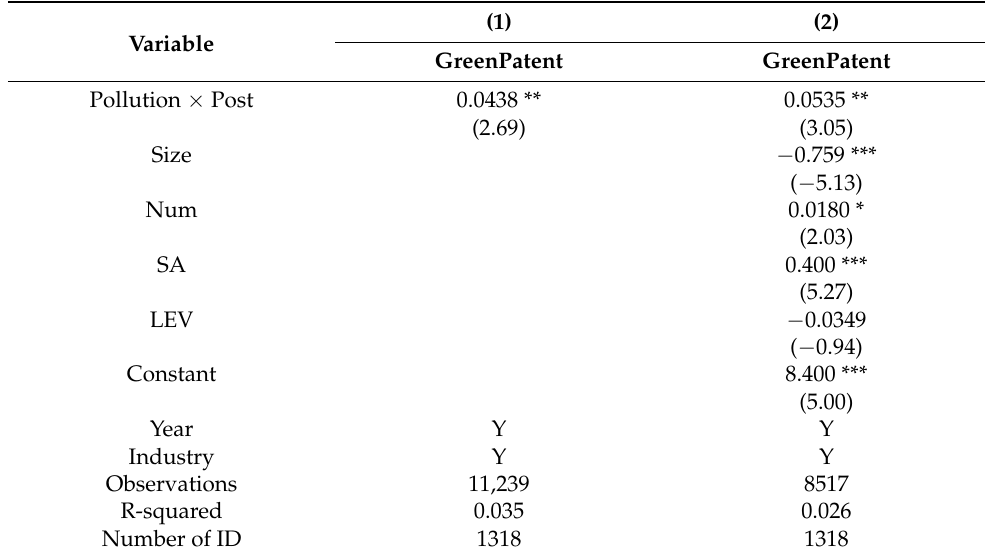
Table 6. Environmental regulation and corporate green innovation: PSM